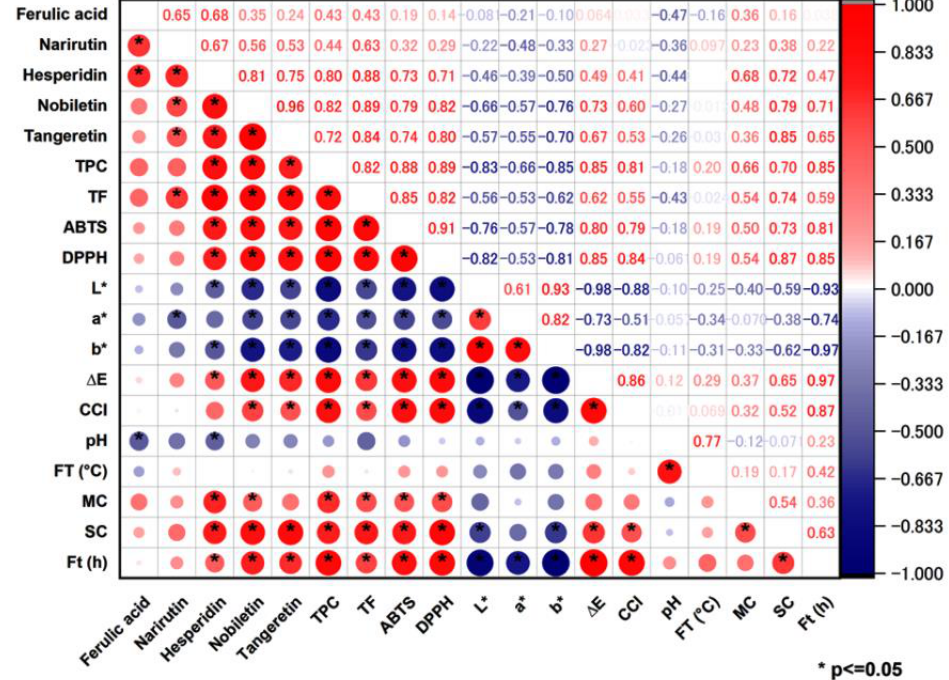
Figure 3. Pearson correlation between the fermentation conditions and the quality attributes of Citrus reticulata peel under solid-state fermentation. Note : CCI = citrus color index, FT = fermentation temperature, MC = moisture content, SC = spore concentration, Ft = fermentation times. * Asterisk denotes significant difference at p < 0.05.